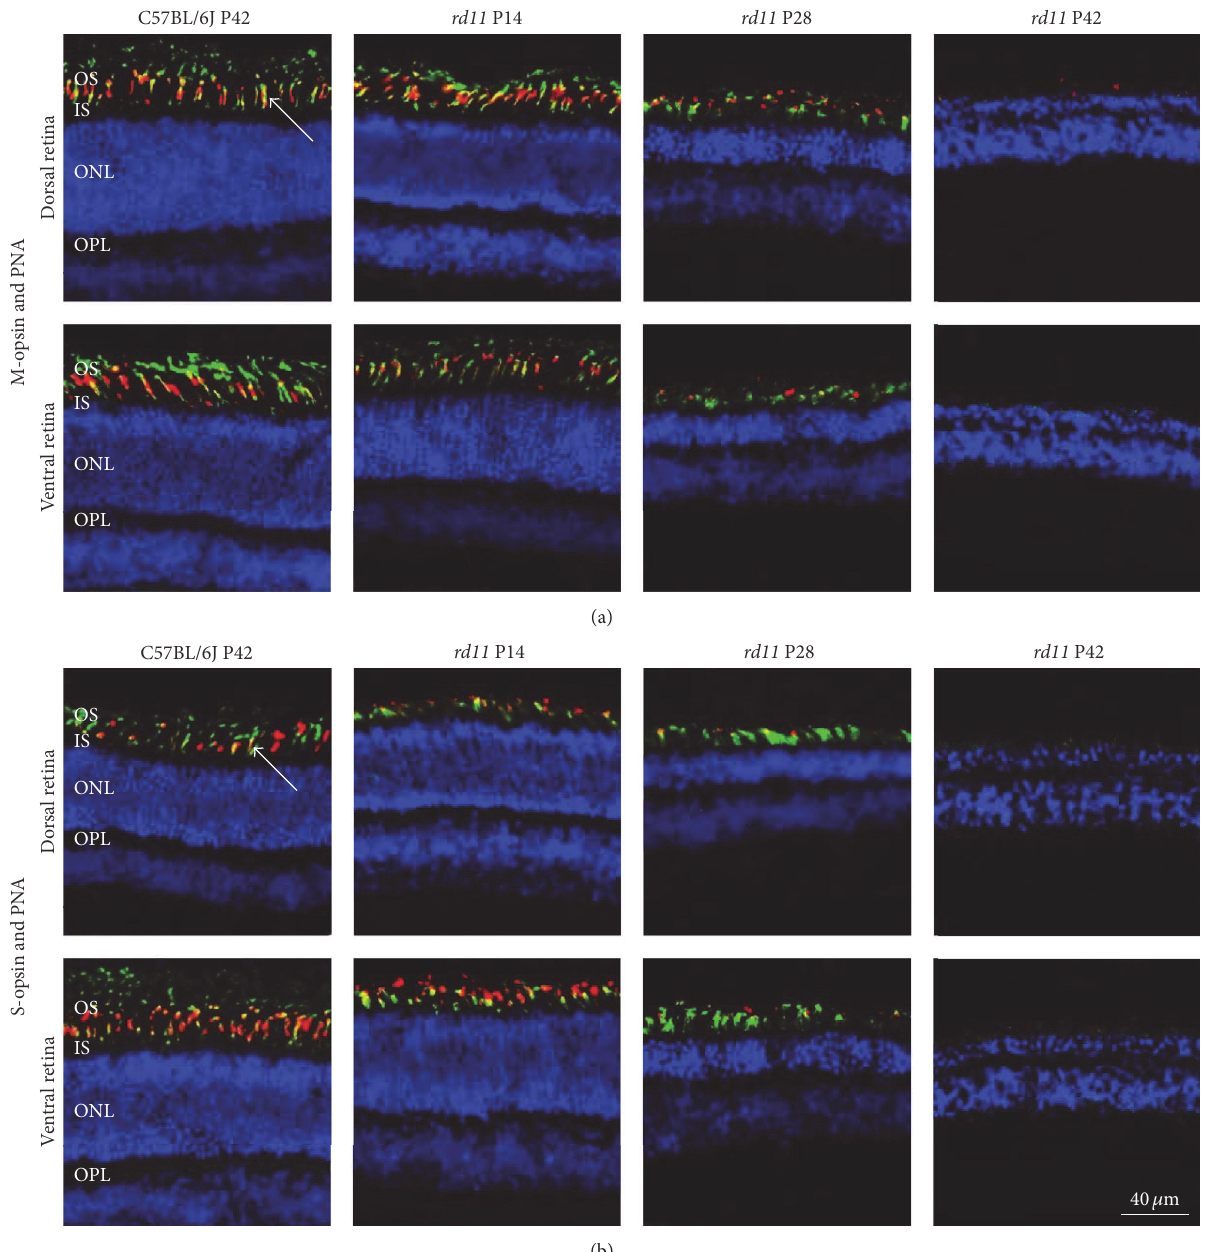
Figure 4: Costaining for L-opsin or S-opsin and PNA in C57BL/6J control and rd11 retina. Immunofluorescence of retinal cryosections from C57BL/6J control and P14, P28, and P42 rd11 mice labeled with L-opsin or S-opsin and PNA lectin. (a) Costaining of L-opsin and PNA. (b) Costaining of S-opsin and PNA. Cells were counterstained with DAPI. Arrows indicate cones with colocalization of PNA and either L- or S-opsin. Red: L-opsin or S-opsin, green: PNA, and blue: DPAI. OS: outer segments; IS: inner segments; ONL: outer nuclear layer; OPL: outer plexiform layer. 𝑛 = 5 retina per